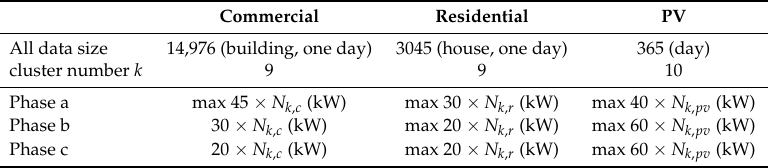
Table 2. Data selection of load and PV output from big data.